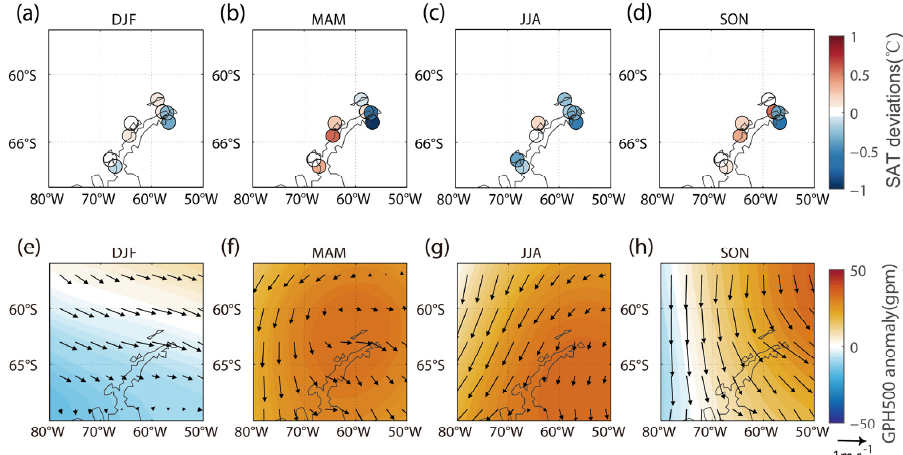
Figure 11. Mode3 of the seasonal combined maximum covariance analysis (CMCA) for the Antarctic Peninsula. ( a – d ), The difference between the ensemble mean of reanalyses and observations for austral summer ( a ), autumn ( b ), winter ( c ), and spring ( d ), respectively. ( e – h ), The regression map of 500 hPa geopotential height (color shading) and u, v component of 10m wind (arrows) onto the time series of CMCA Mode3 for austral summer ( e ), autumn ( f ), winter ( g ), and spring ( h ), respectively.